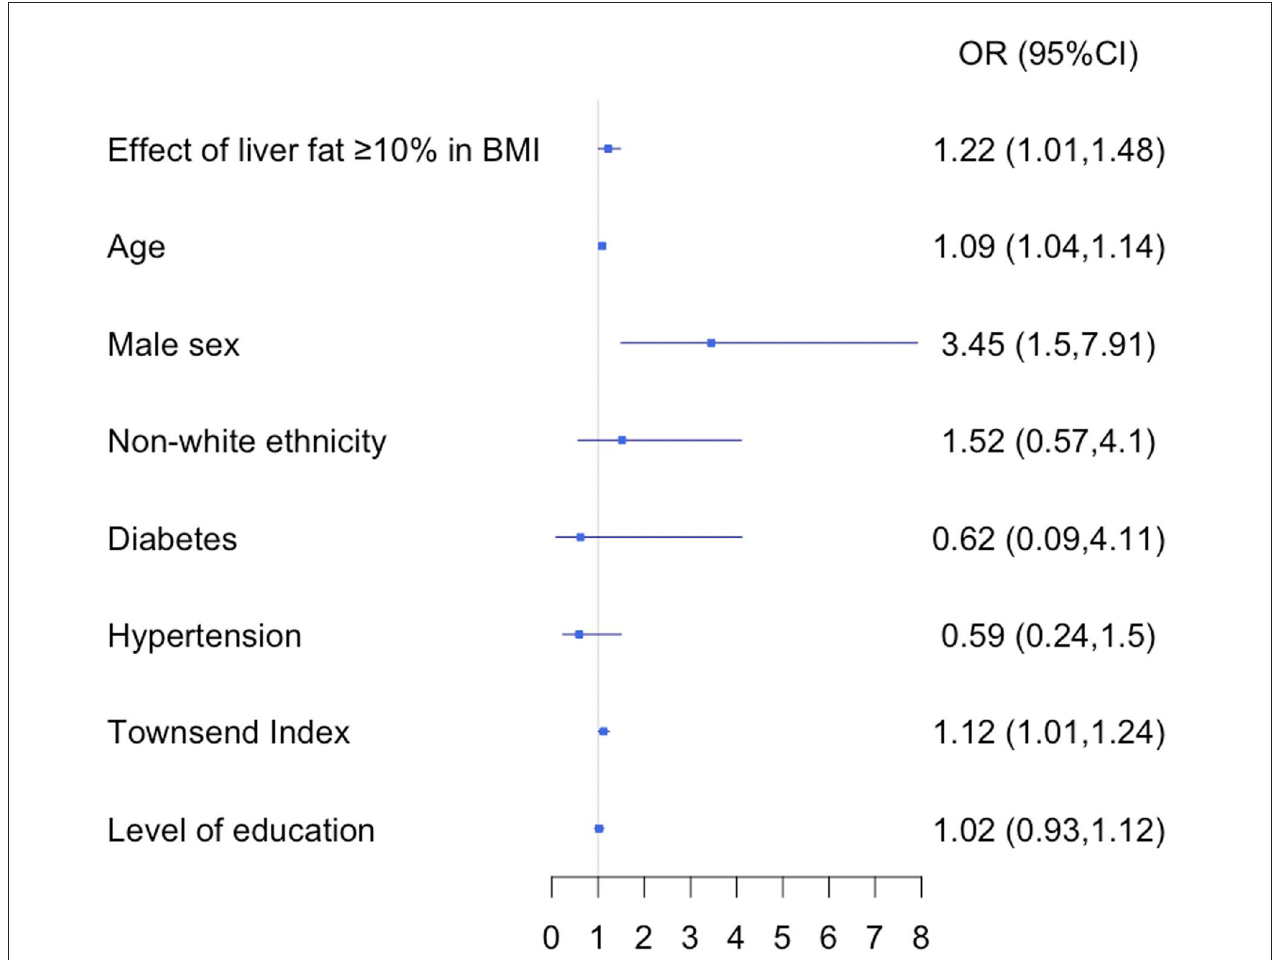
FIGURE 3 | Multivariate stepwise logistic regression, discriminators of being positive hospitalized participants vs. positive non-hospitalized. OR, odds ratio; CI, confidence interval; BMI, body mass